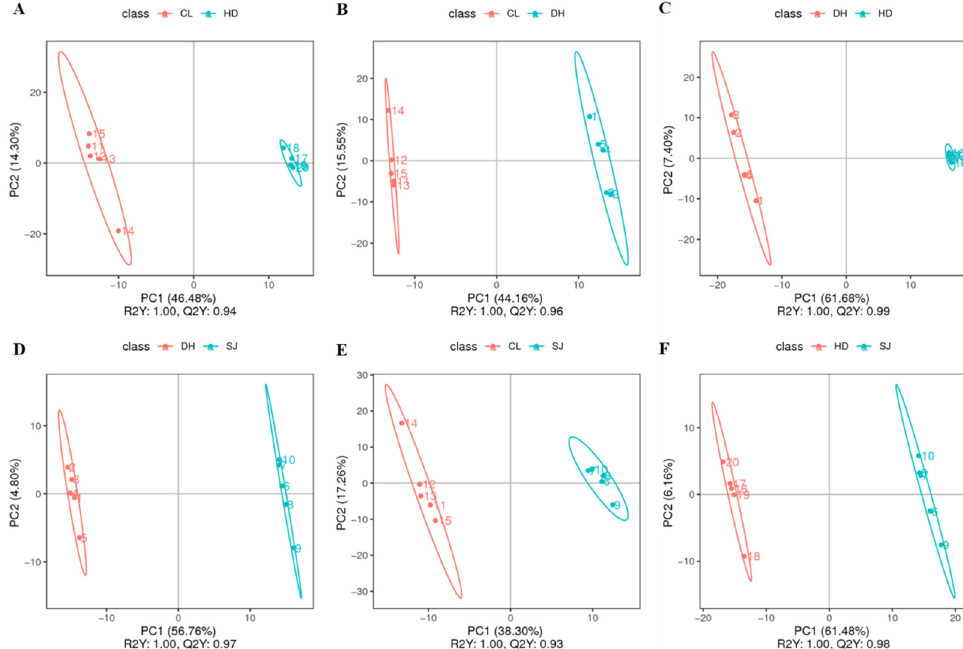
Figure 2. PLS-DA score scatter plots. ( A ) CL vs. HD; ( B ) CL vs. DH; ( C ) DH vs. HD; ( D ) DH vs. SJ; ( E ) SJ vs. CL; ( F ) SJ vs. HD. Notes: Daohuaxiang (DH), Huaidao No. 5 (HD), Songjing (SJ), and Changlixiang (CL).